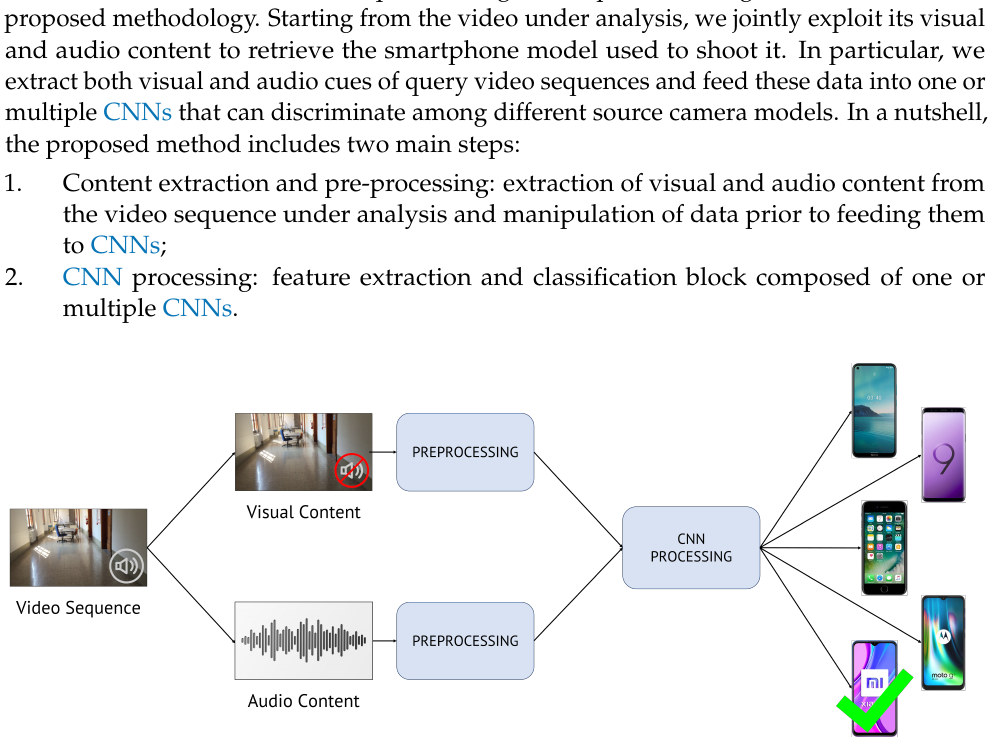
Figure 2. Pipeline of the proposed method to solve multi-modal camera model identification on video sequences. Given a query video sequence, we extract and pre-process its visual and audio content, then feed these data to CNNs in order to identify the actual source camera